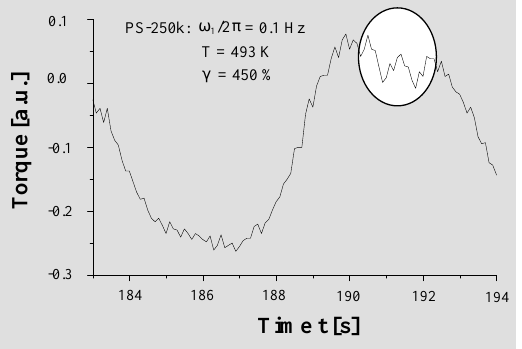
Figure 5a (left): A typical time signal for a oscillatory measurement with PS-250k at T = 493 K, n 1 = 0.1 Hz and g 0 = 450%. The circle high- lights the time signal where a sudden decay and a slow- er built up characteristic for saw tooth figure is detected. Figure 5b (right): FT-rheolo- gy spectra of a). The spec- trum is magnified between n = 0.35 Hz and n = 0.8 Hz by a factor of